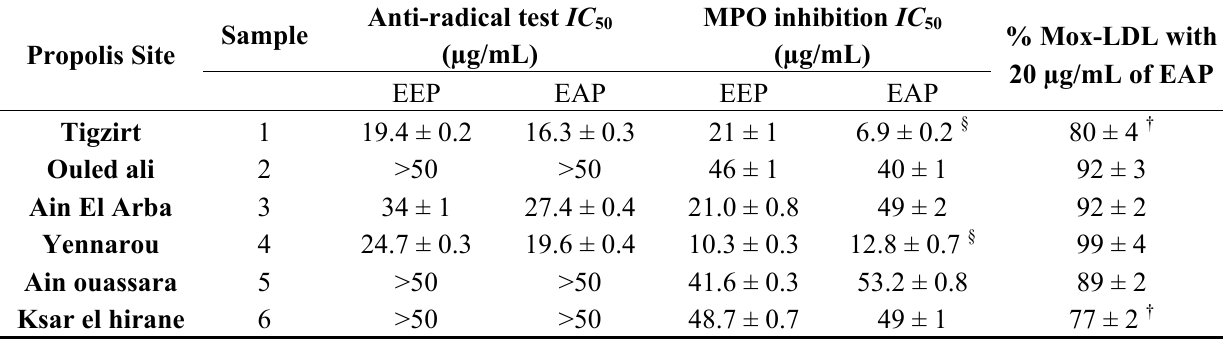
Table 2. Antiradical activity and Myeloperoxidase (MPO) inhibition activity of ethanol and ethyl acetate extracts, IC value of ascorbic acid as antiradical scavenging is 50 3.1 ± 0.2 µg/mL.